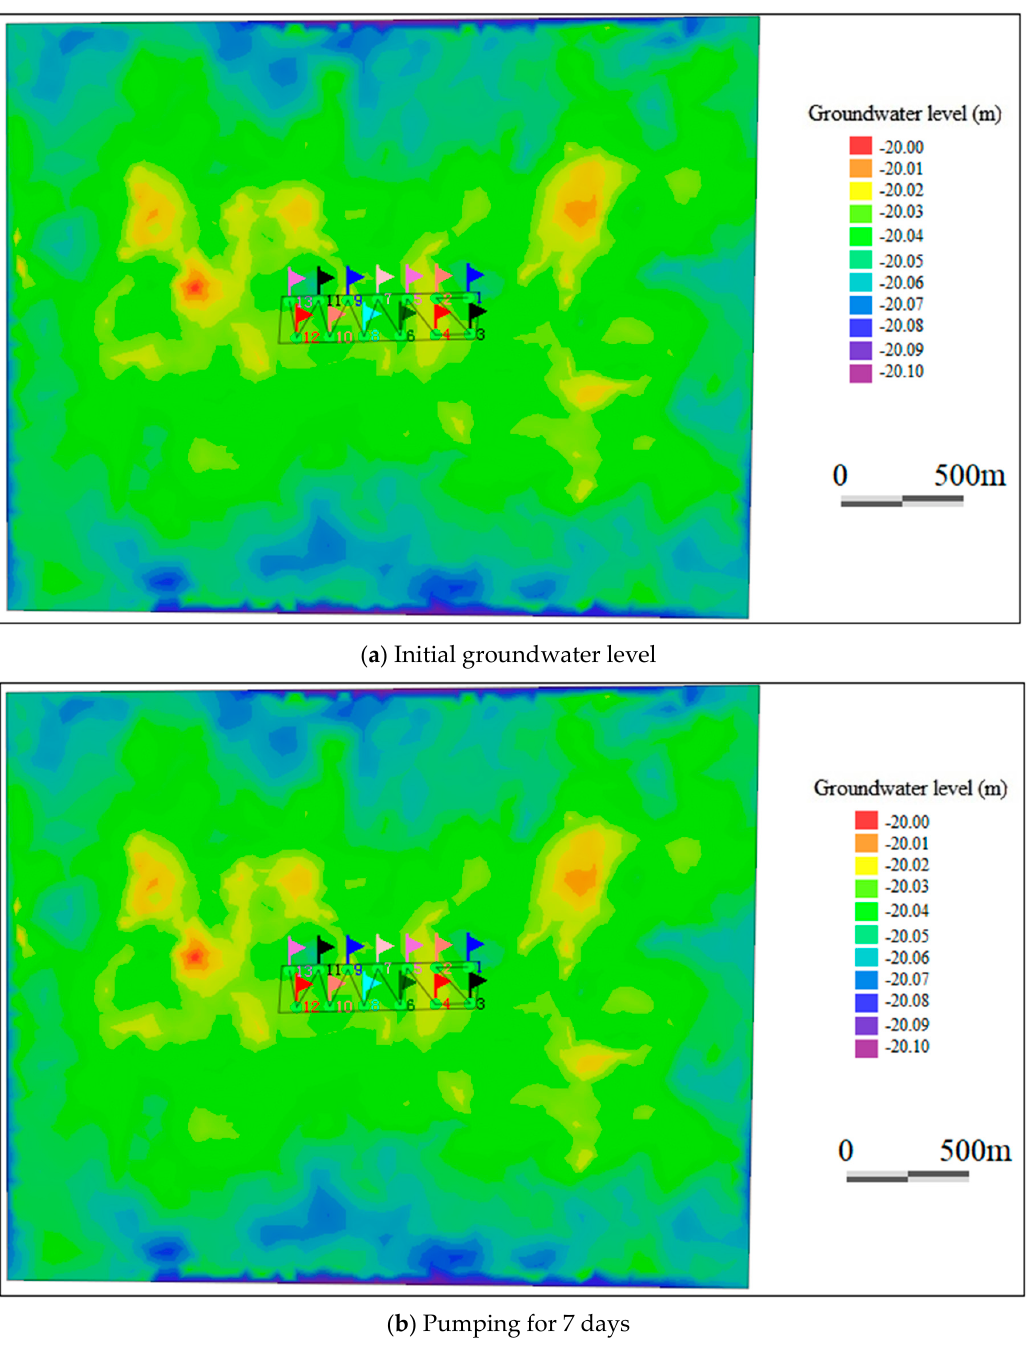
Figure 14. Groundwater level of the second confined